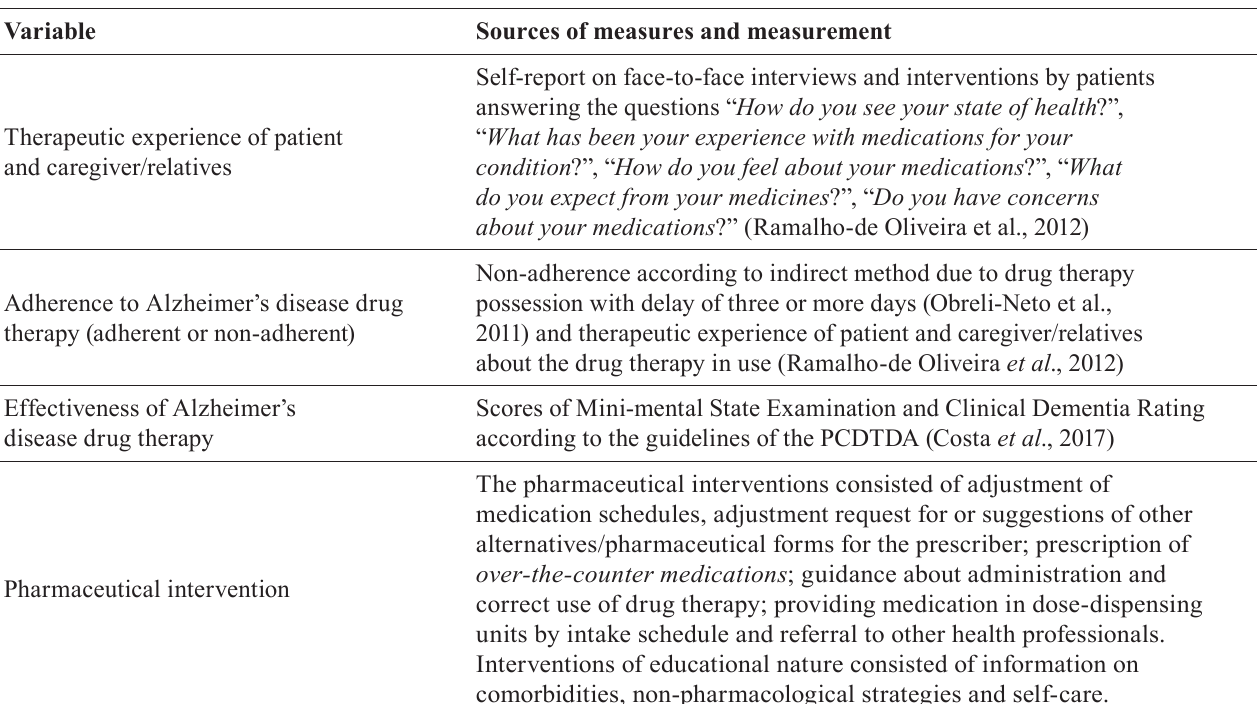
TABLE I - V ariables of interest and sources of measures and measurement